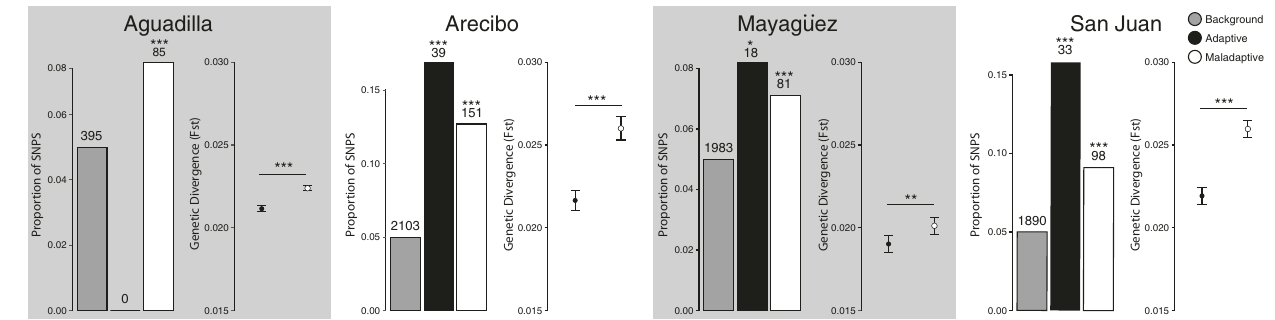
Fig. 7 Repeated increases in urban – forest genetic divergence associated with maladaptive plasticity. Comparisons of genetic divergence ( F ST ) among heat tolerance-associated genes in four municipalities, representing independent urban colonization events across Puerto Rico 58 . Bar graphs display the proportion single-nucleotide polymorphisms (SNPs) within the adaptive (black) and maladaptive (white) gene sets that occur beyond the p = 0.05 empirical distribution of genetic divergence ( F ST ), based on the transcriptome-wide background (gray). Asterisks indicate a signi fi cant enrichment of outliers within a gene class (* p < 0.05, ** p < 0.01, *** p < 0.001, two-sample equality of proportions test with continuity correction). No outlier gene SNPs were found in the adaptive plasticity gene set within Aguadilla. Dot plots display mean ± 1 SE of genetic divergence ( F ST ) for SNPs within the adaptive (black) and maladaptive (white) plasticity gene classes. Asterisks indicate signi fi cant differences in mean divergence (* p < 0.05, ** p < 0.01, *** p < 0.001, Welch two-sample t -test). All 130 animals for which we had sequence data were used in